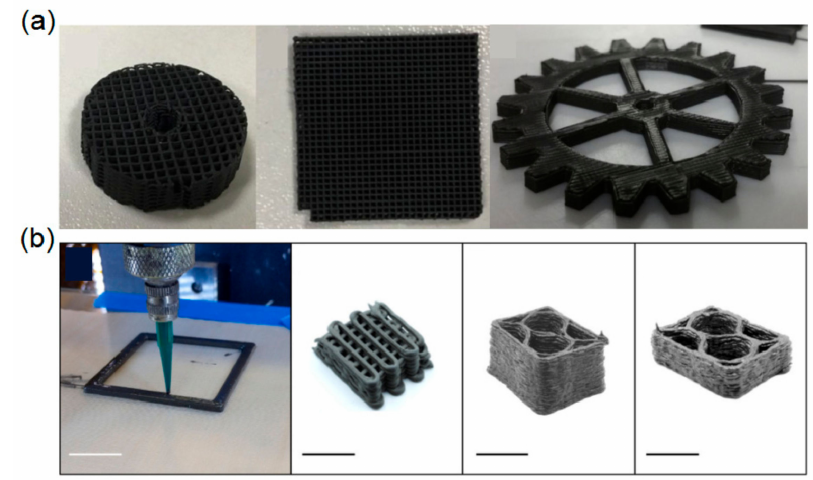
Figure 8. ( a ) Robocasting of HfB 2 -based UHTC. Reproduced with permission from [110]. ( b ) Di- rect ink writing of ZrB 2 -SiC UHTC chopped fiber ceramic composites, all scale bars were 1 cm. Reproduced with permission from